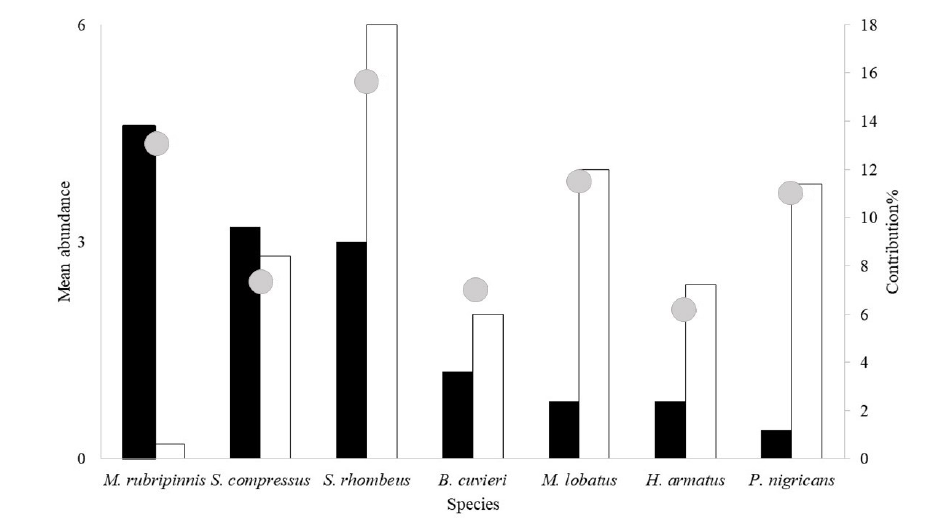
FIGURE 3 | Mean abundance and relative contribution of the most important species accounted by SIMPER analysis for both seasons of the hydrological cycle. Black and white bars represent the mean abundance of each species ate high water and low water season, respectively. The gray circles are the relative contribution estimated by the SIMPER